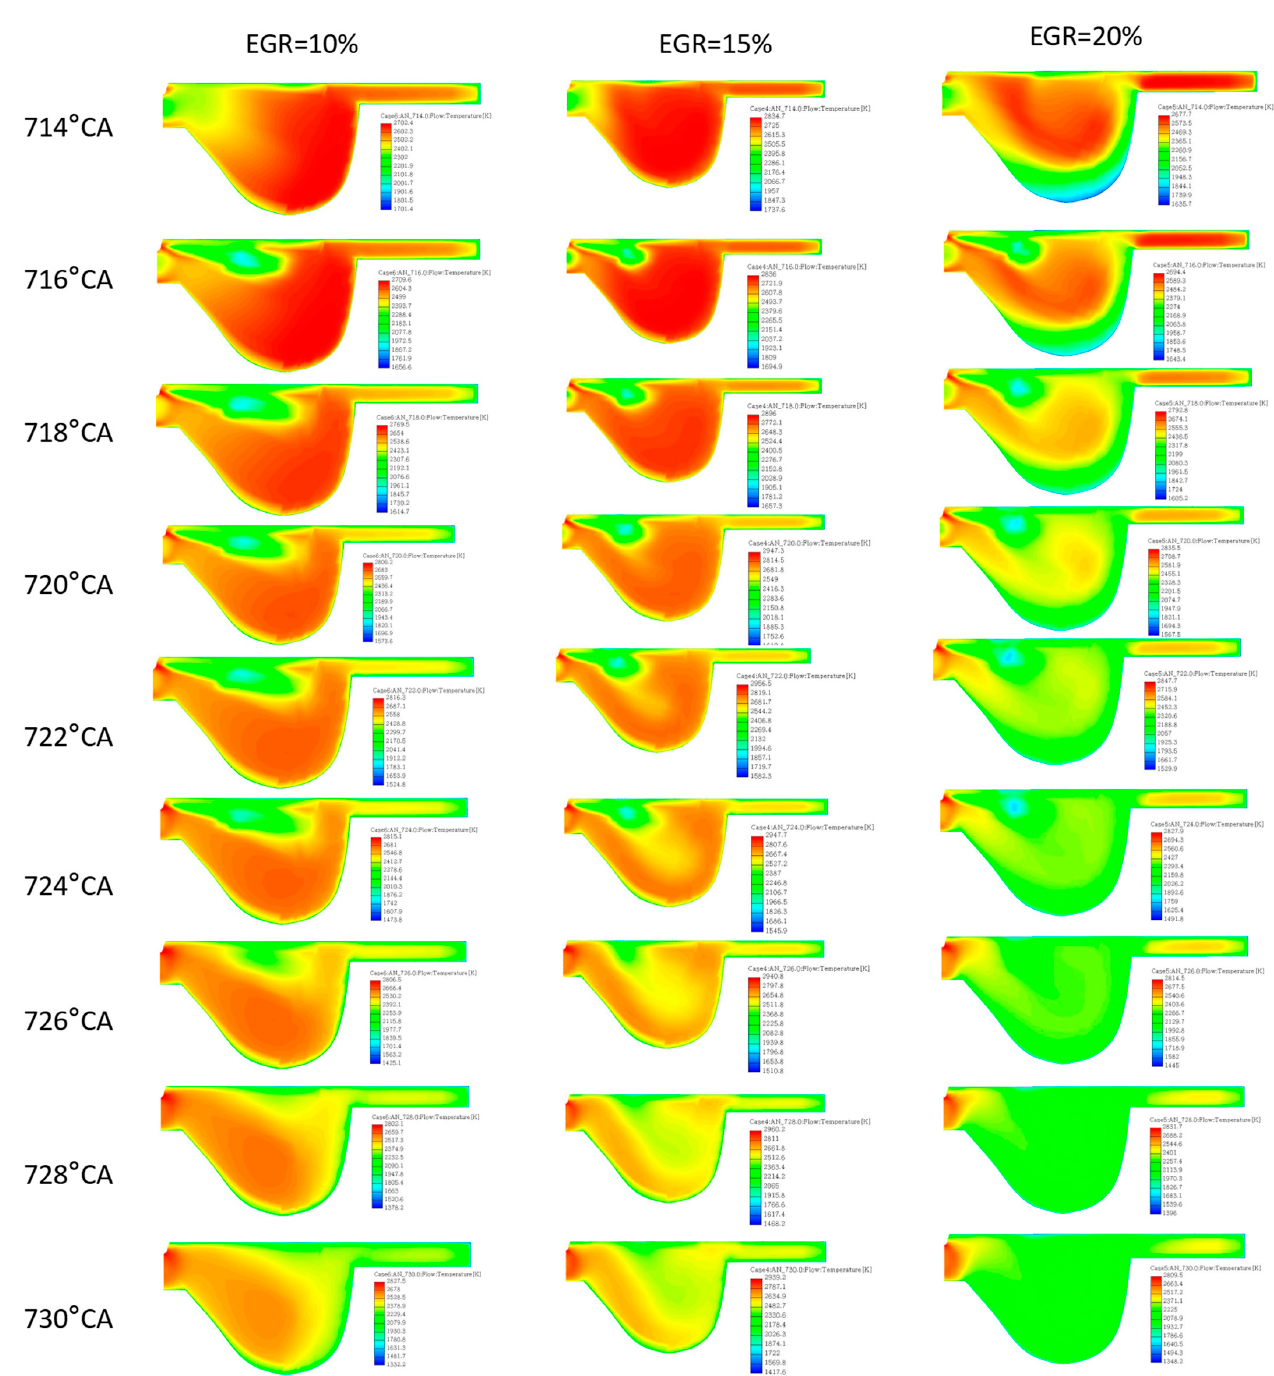
Figure 10. Cylinder temperature field distribution at various crank angles and EGR rates.